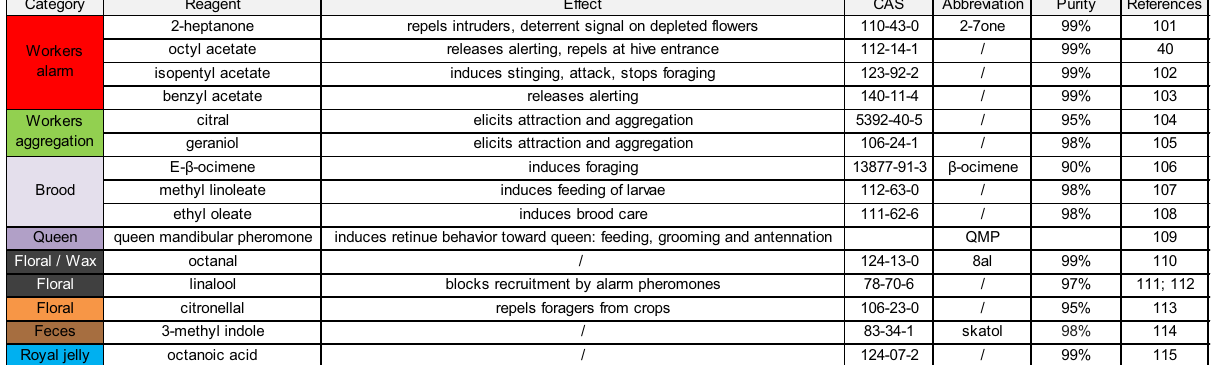
Table 1. Detailed description of the odorants, their source of production and effect on workers bees. Colors correspond to the legend on the graph: alarm (red), aggregation (green), brood (light purple), and queen (purple) pheromones, and floral odorants (black), repulsive odorant (orange), odor of feces (brown) and of royal jelly (blue). All odorants were obtained from Sigma-Aldrich (Deisenhofen, Germany) except for the queen pheromone QMP, which was a commercial stick purchased as BeeBoost ®, Pherotech, Delta, Canada 40,101–115